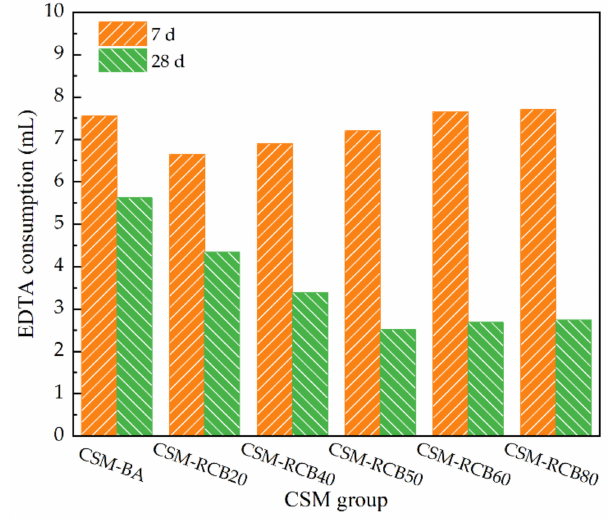
Figure 13. The EDTA consumption with curing for CSM